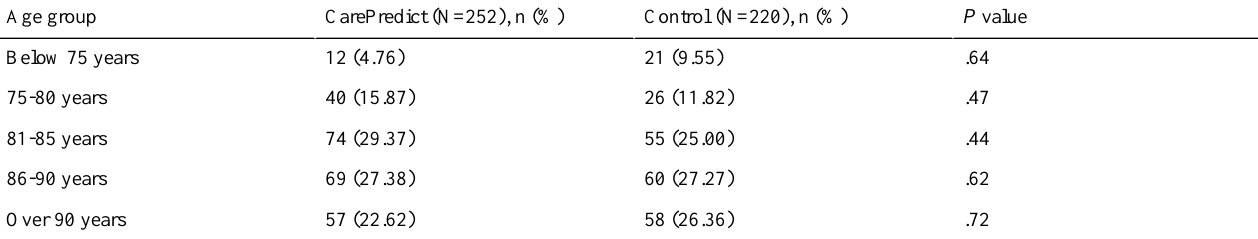
Table 1. Resident age in the CarePredict and control assisted-living